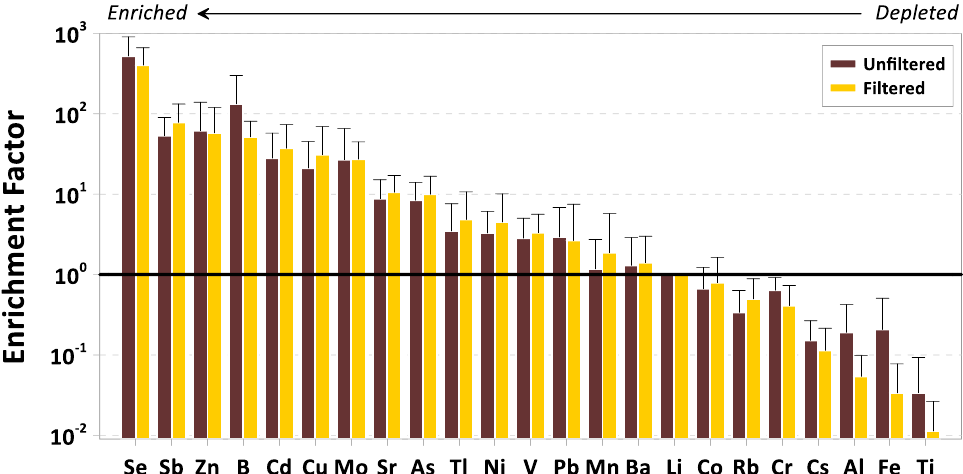
Figure 7. Enrichment factors (EFcrust) of trace elements at all the sampling sites and both for the concentrations of the trace elements in the unfiltered aliquot (brown) and in the filtered aliquot (yellow). The standard deviation is shown.